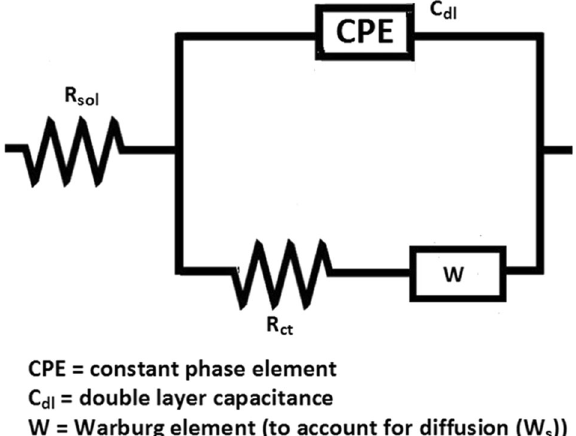
Fig. 8 Equivalent circuit. Equivalent circuit used to fi t impedance spectra in order to evaluate diffusion control